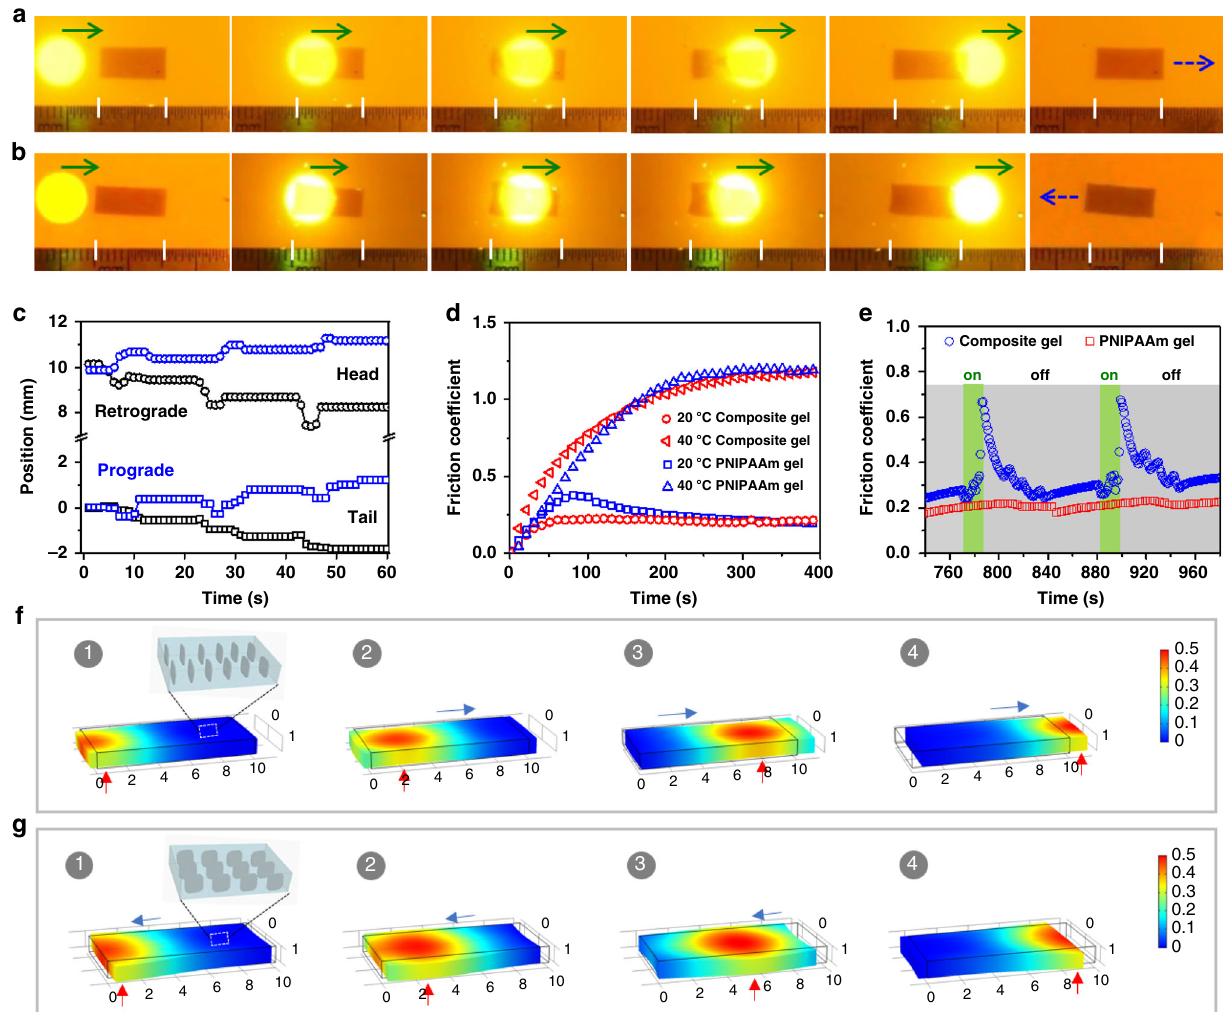
Fig. 4 Photo-steered crawling of the monodomain hydrogels. a , b Snapshots to show the crawling motions of the slender hydrogel sheets with alignment of NSs along ( a ) or perpendicular ( b ) to the long axis under the scanning of a light beam. A cut-off fi lter is applied to fi lter out the strong green light for better visualization of the hydrogel under light irradiation. Green and blue arrows indicate the light scanning direction and motion direction, respectively. Gel dimensions, 10 mm × 5 mm × 1 mm; power intensity, 3.5 W cm − 2 ; scanning speed, 1.7 mm s − 1 . c Time-variant displacements of the head and the tail of the slender gel sheets under cyclic scanning of a light beam. d , e Variations of the friction coef fi cient of the PNIPAAm hydrogel and the NS/AuNP- containing PNIPAAm hydrogel against a PVC substrate as a function of test time at 20 and 40 °C ( d ) or under cyclic irradiation of a green-light beam at 20 °C ( e ). f , g Simulation results to show the kinematics of the forward ( f ) and retrograde ( g ) crawling motions of the monodomain hydrogel on the basis of photo-directed localized isochoric deformation and dynamic friction modulation. The red and blue arrows indicate the anchoring spot and motion direction of the gel. The color scale indicates the normalized